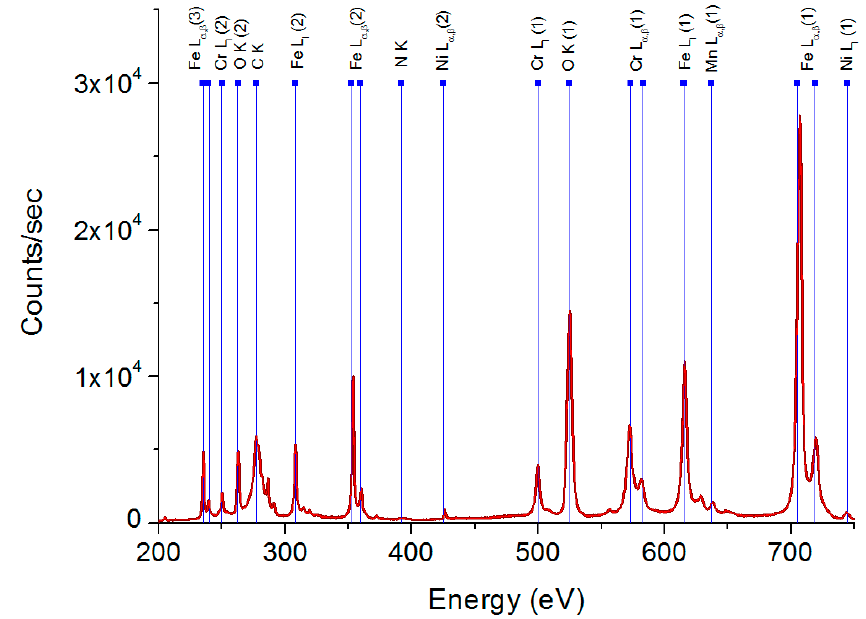
Figure 7. Measured sample spectrum of stainless steel. The data (red) are not corrected for the total quantum efficiency. X-ray emission lines are identified (blue vertical lines), and the observed diffraction order is noted in brackets.